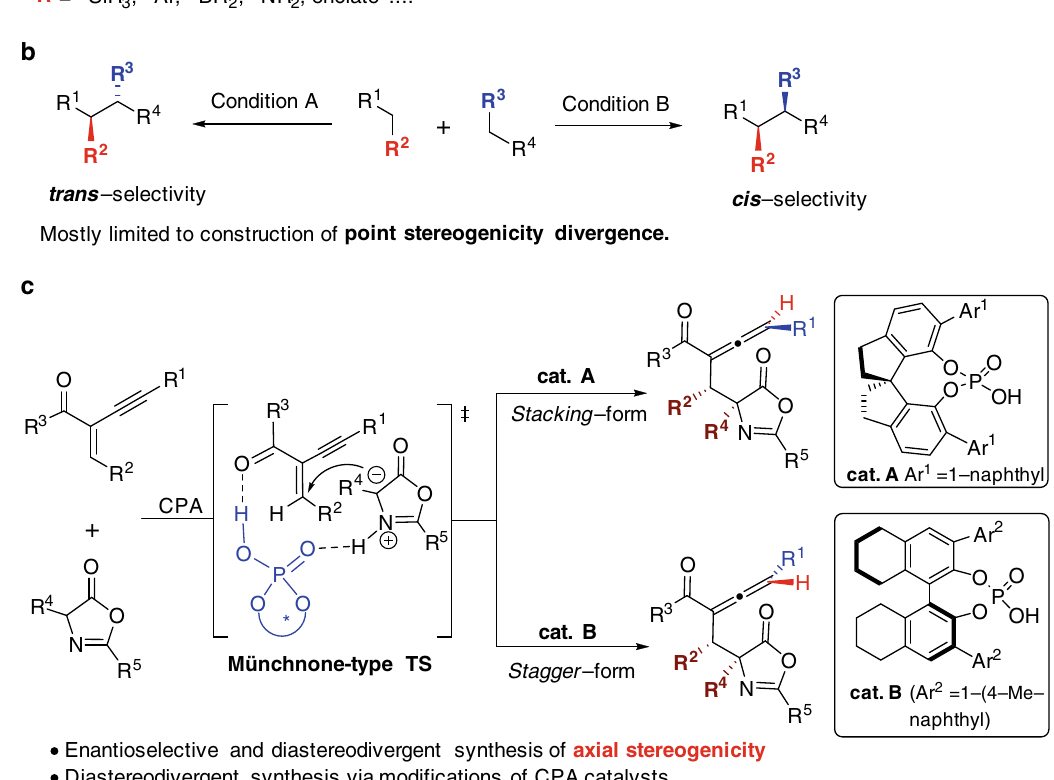
Fig. 1 Asymmetric synthesis of chiral allenes and stereodivergent synthesis. a Asymmetric synthesis of chiral allenes via enantioselective additions of activated 1,3-enynes. b Asymmetric stereodivergent catalysis was limited to the construction of point stereogenicity divergence. c Asymmetric stereodivergent construction of axial stereogenicity via modi fi cations of chiral phosphoric acid